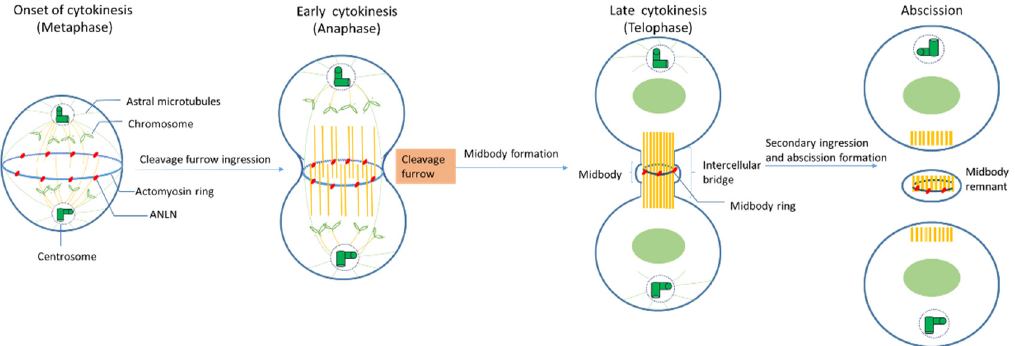
Figure 2. The roles of ANLN during cytokinesis.